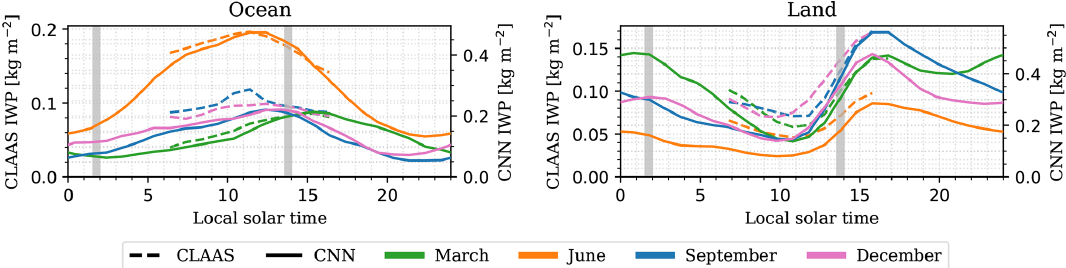
Figure 11. Monthly mean diurnal cycles for 4 months in 2012 from CLAAS and the CNN, IR-only QRNN retrieval for the areas in Fig. 2. The QRNN expected value is used as the retrieval value. Local solar time (LST) approximated from UTC as LST = UTC + 12h / 180 ◦ · longitude. The grey areas indicate the LST coverage of the DARDAR profiles in the training set. Note the different vertical axes.